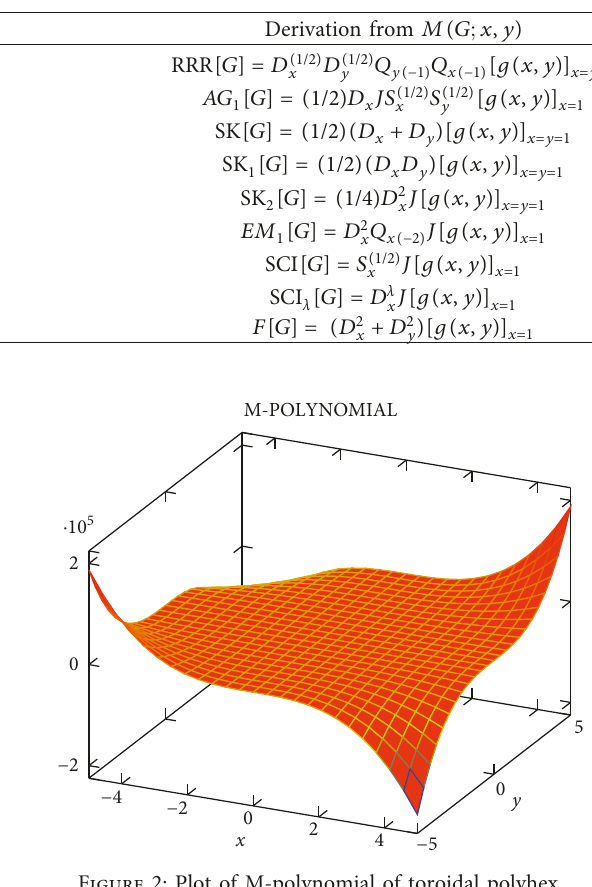
Table 1: Degree-dependent topological indices via M-polynomial.